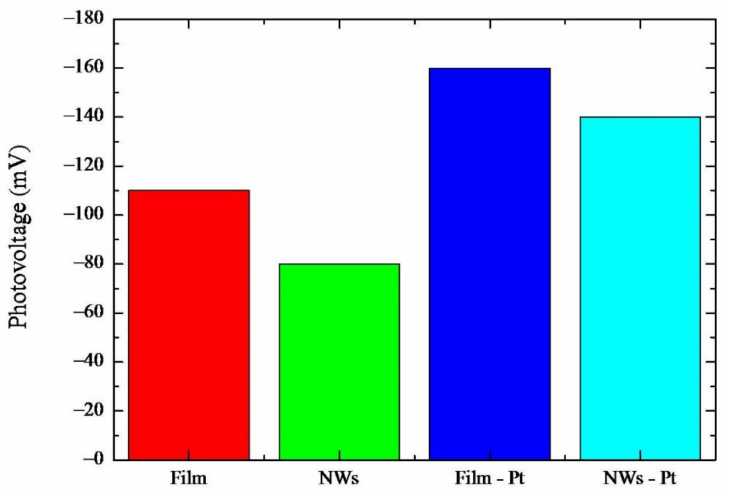
Figure 6. Photovoltage for various samples: “Film”, “NWs”, “Films-Pt”, and “NWs –Pt”. An increase in VOC (in module) is observed once the irradiation is started, and it reaches a steady-state value after about 10 min of continuous illumination (not shown). The photovoltage measured in the “Film” sample was about − 110 mV. Upon nano-structuration (see “NWs” sample), the photovoltage was reduced to − 80 mV. Thanks to the presence of the nanoporous Pt film on the rear side of the samples an increase in the photovoltage was observed; indeed, “Film-Pt” and “NWs-Pt“ samples had photovoltage values of − 160 mV and − 140 mV,